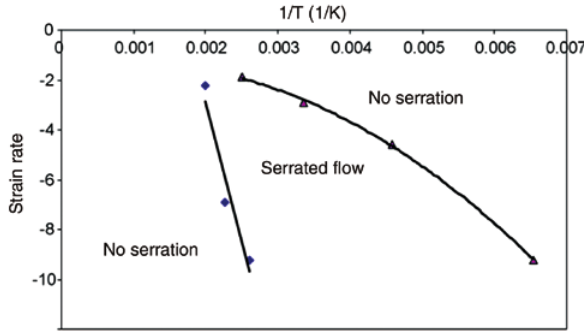
Figure 3: Range of strain rate-temperature for the occurrence of serrated follow of the PLC in the AA-5083 alloy [16].